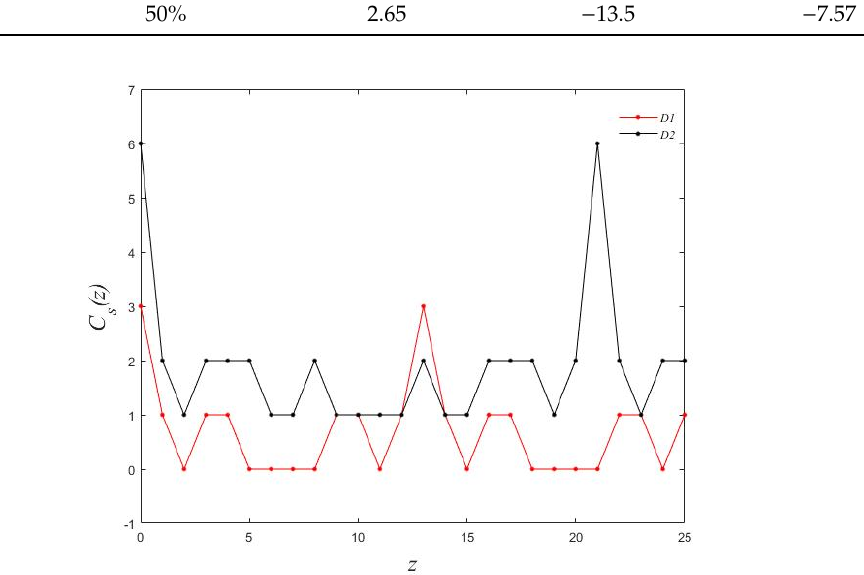
( ) ADS C z of D. Figure 1. Autocorrelation function C ADS s ( z ) of D s